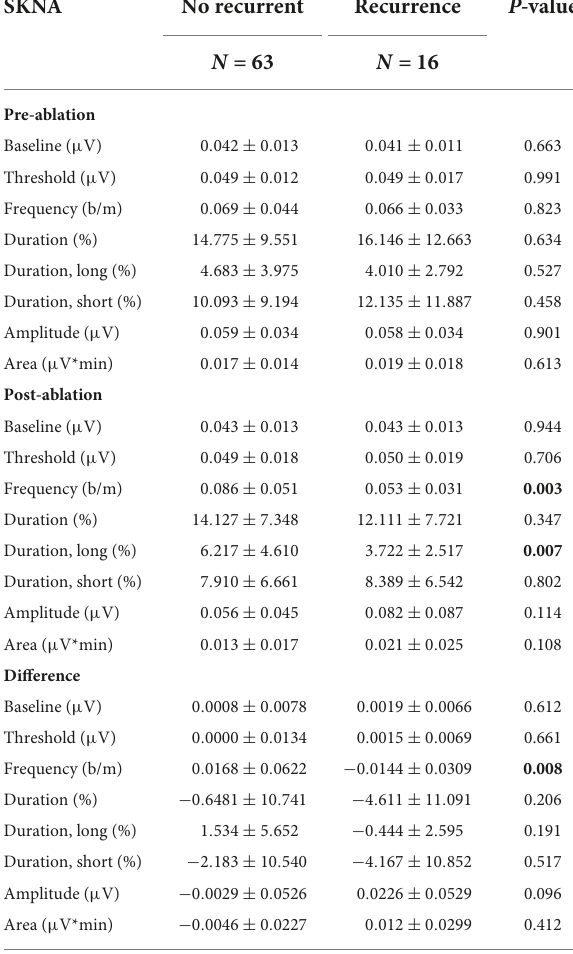
TABLE 4 SKNA data (5